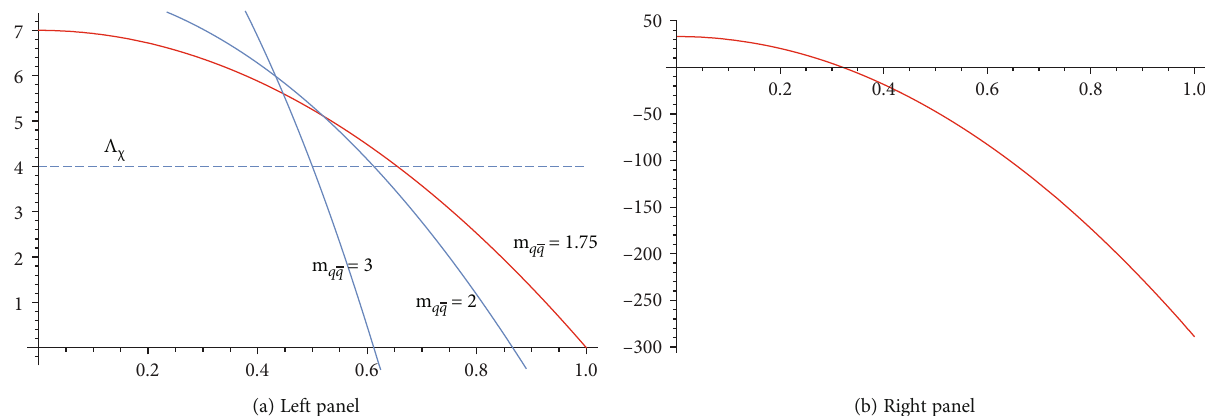
ð r , m Þ against ( r , m s q (cid:1) q